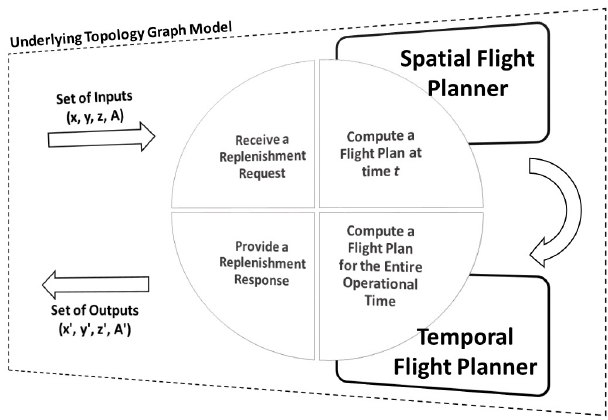
Figure 4. GA-based energy aware flight path planning framework ( A ) of an ABS such as remaining battery percentage,